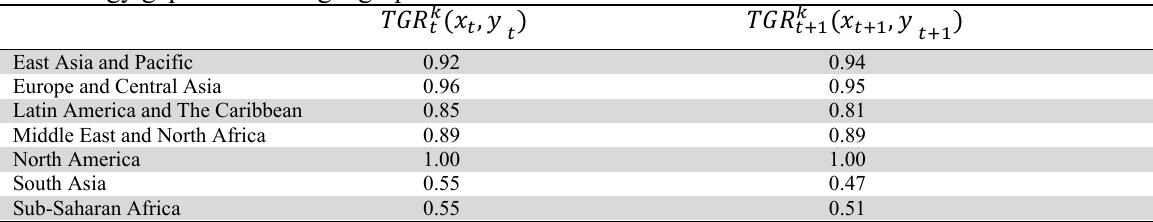
Technology gap ratio at the geographical